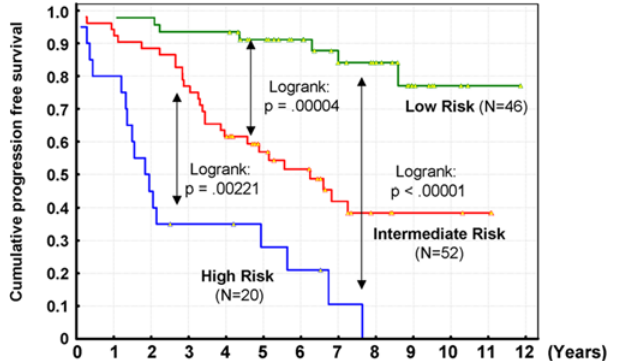
Figure 5. Progression-free survival in the 3 risk tiers. Kaplan- Meier survival curves for each of the 3 risk tiers are shown. The 2-year progression-free survival rates of HR, IR, and LR were 45%, 88.5%, and 97.8%, respectively. Four-year progression-free survival rates were 35%, 63.5%, and 93.5%, respectively. Differences in progression-free survival among these 3 risk tiers were statistically significant (log-rank test).